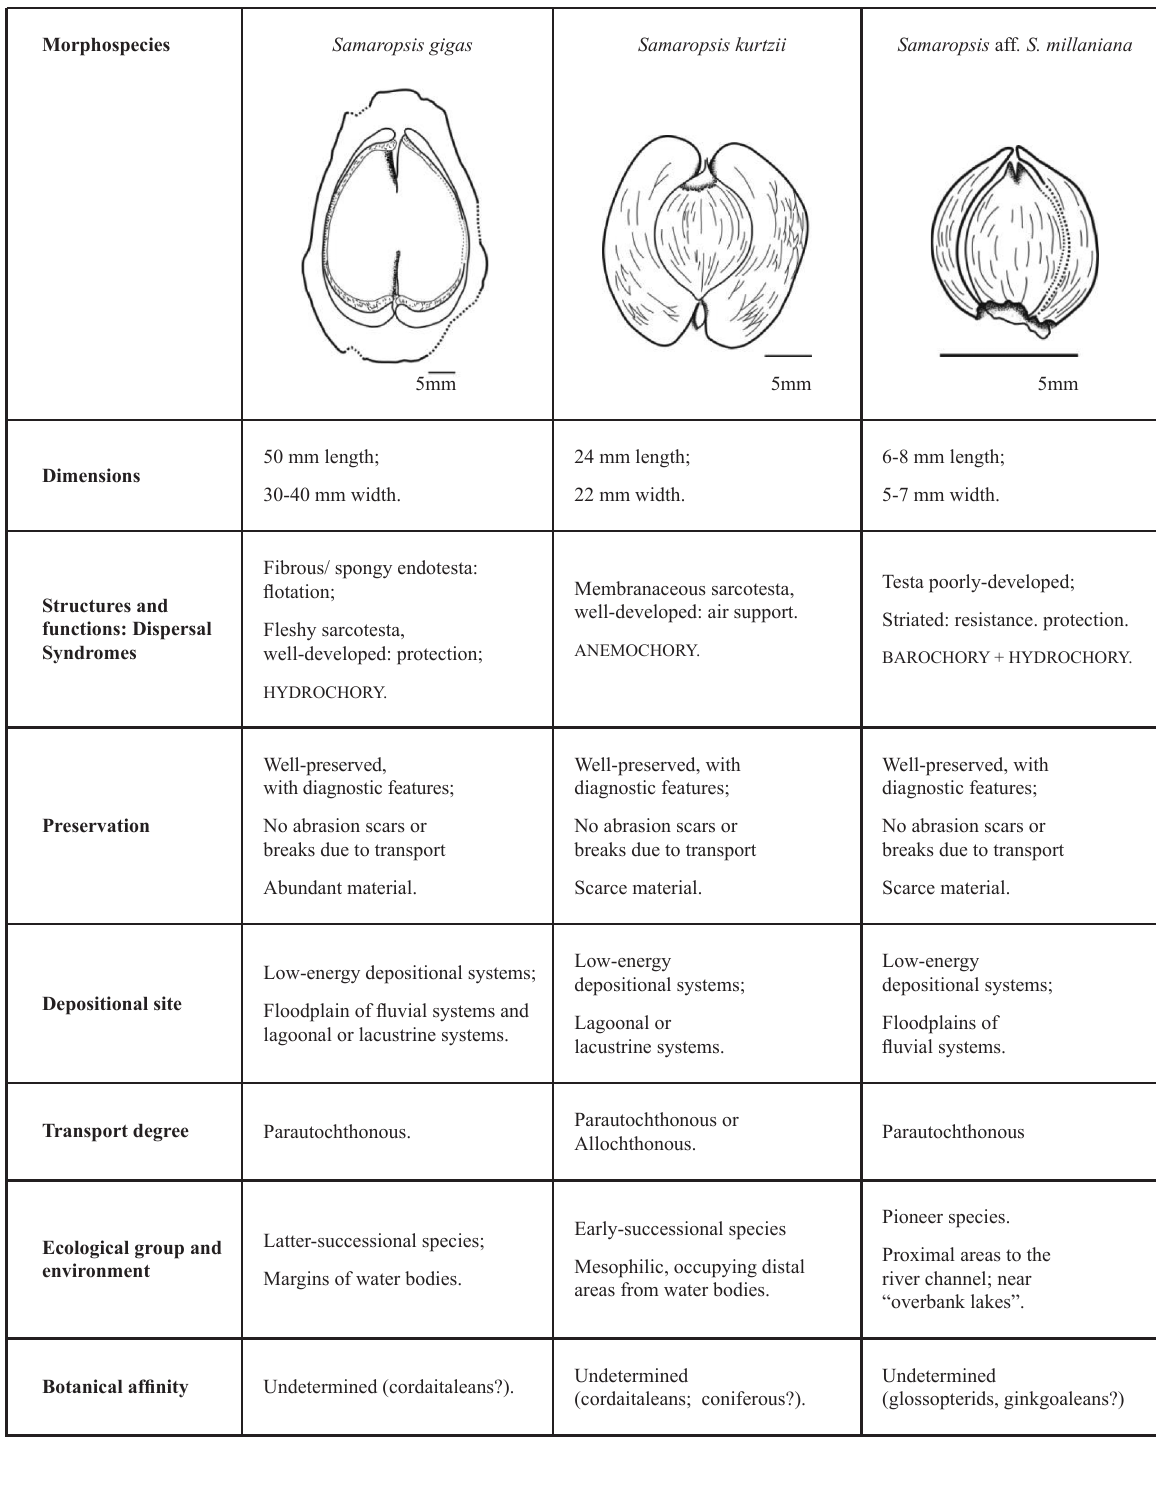
Comparative table summarizing the characteristics of the species